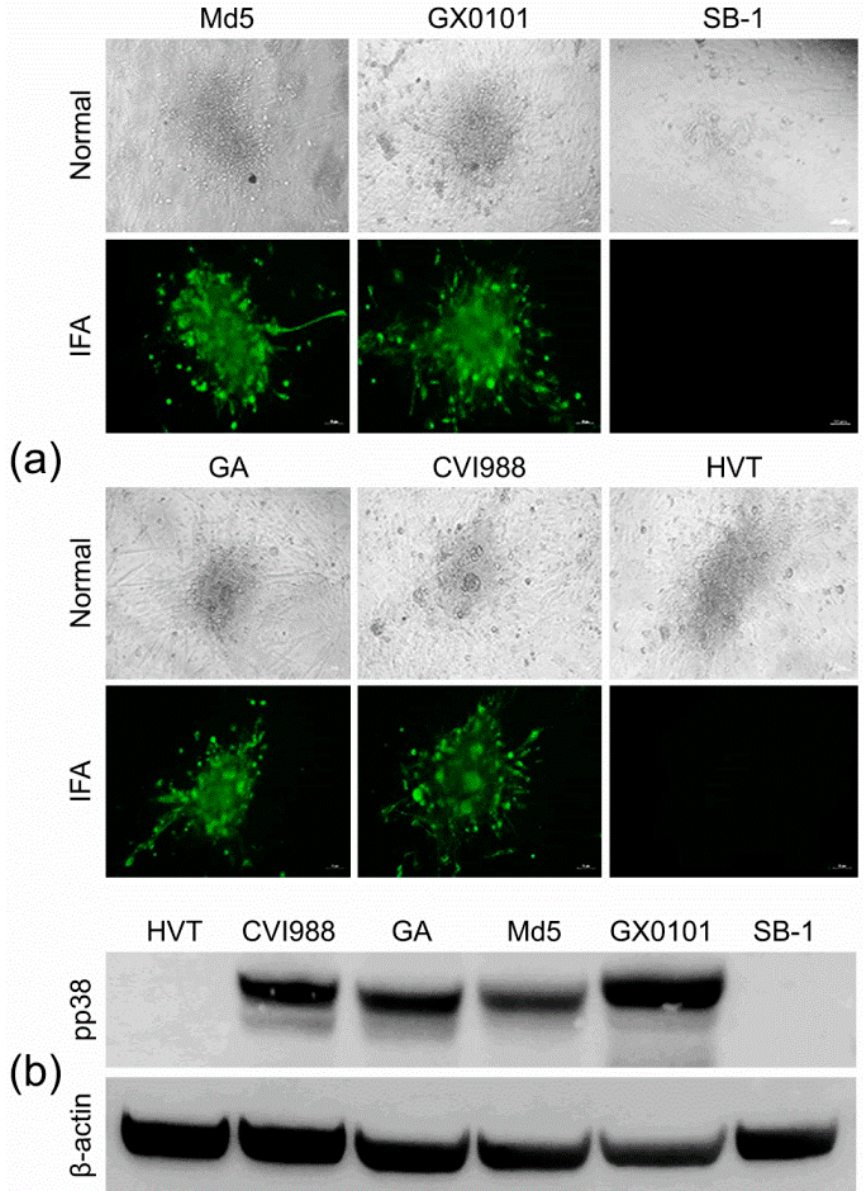
Figure 6. Reactivity of the mAb 31G7 to different serotypes of MDVs: ( a ) Immunofluorescence assays performed for the detection of the reaction spectrum of the pp38 mAb 31G7 to different serotypes of MDVs. Normal images of GX0101 or GX0101 ∆ pp38 plaques under regular light; IFA, immunofluorescence assay. ( b ) Western blot analysis performed for the detection of the reaction spectrum of the mAb 31G7 to proteins from CEFs infected with different serotypes of MDVs. Chicken β -actin was used as the protein loading control. Scale bar = 50 µm.